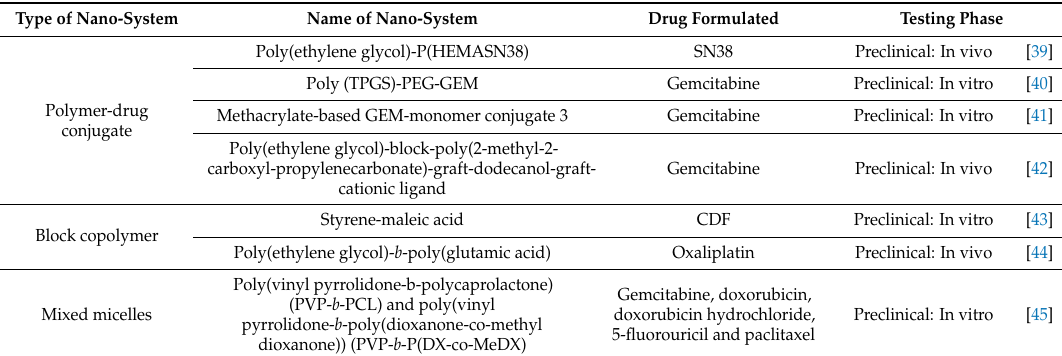
Table 1. Nanoparticle based drug delivery systems for PC